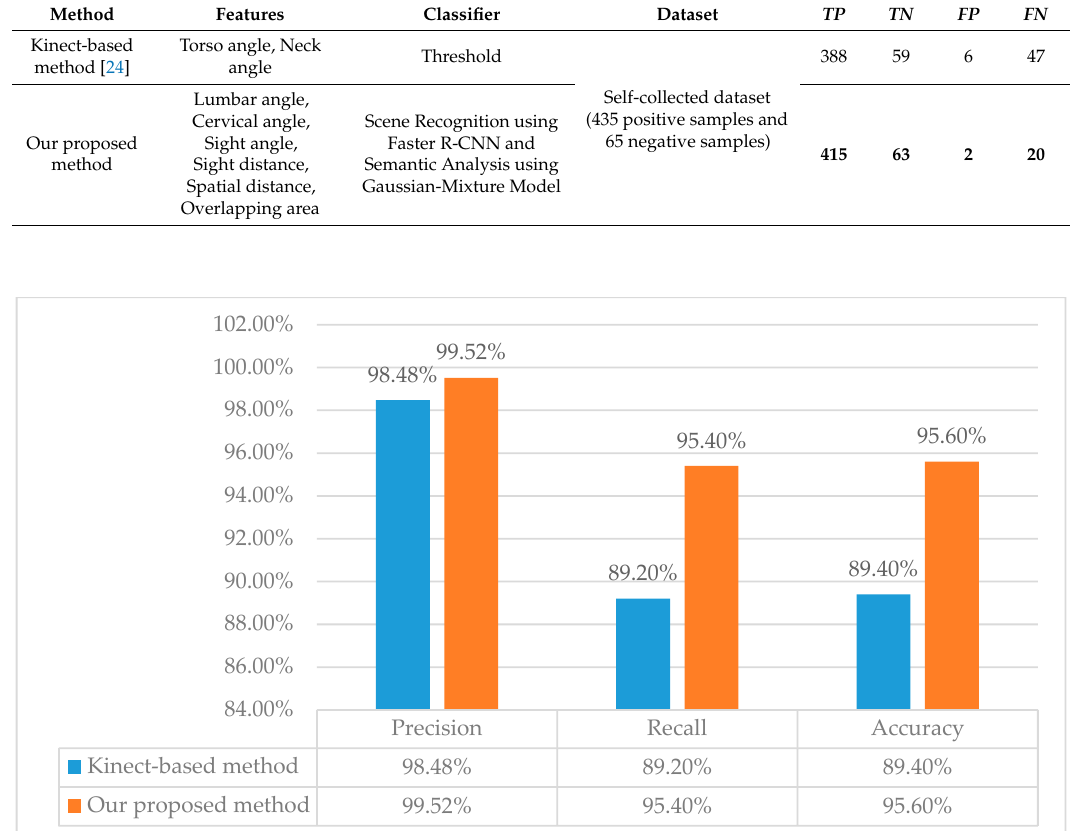
Table 4. Overall comparison of our method with some other methods.